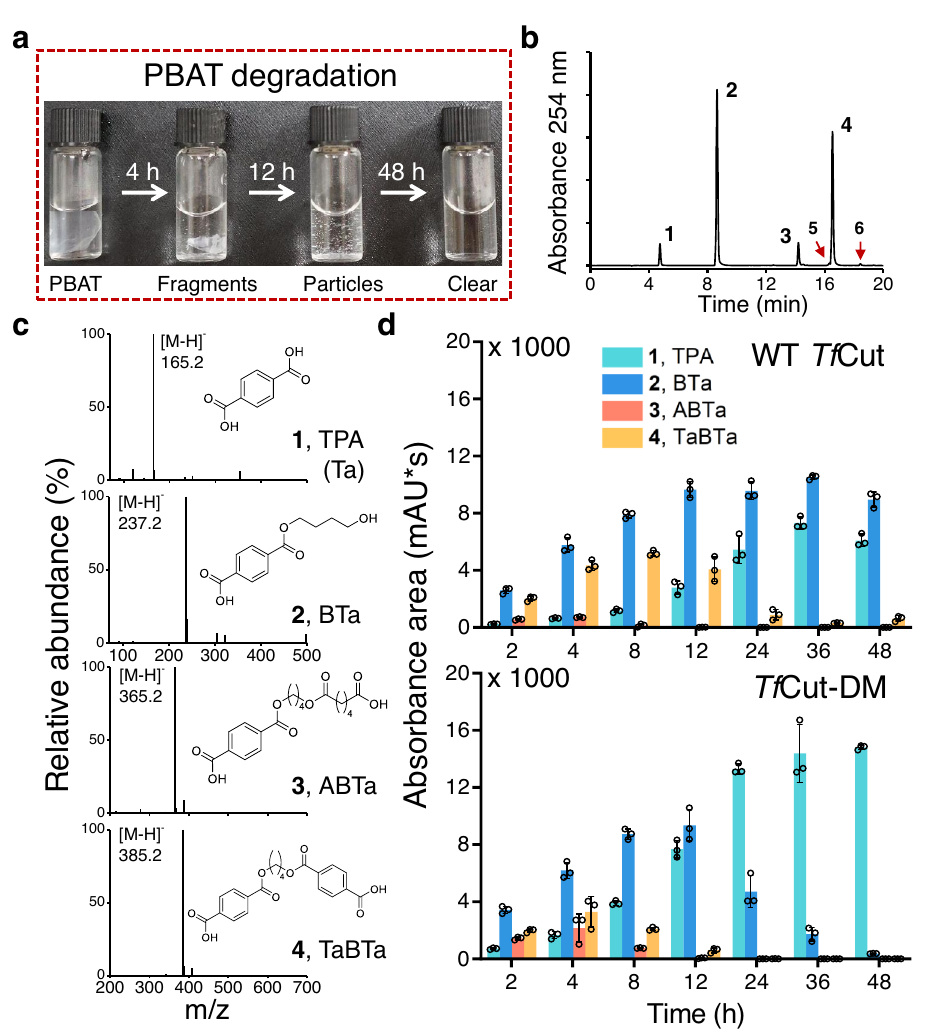
Fig. 2 | Degradation ofPBAT by Tf Cut. a PBAT fi lm hydrolysiscatalyzed by Tf Cut at70°Covertime.Theoptimaltemperatureof Tf Cutwasdeterminedandshownin Supplementary Fig. 1. b HPLC chromatograms of PBAT hydrolytic products at 4h. c The structures of the intermediates in b were identi fi ed based on the mass spectrum. d The time-course of four major PBAT-hydrolytic intermediates